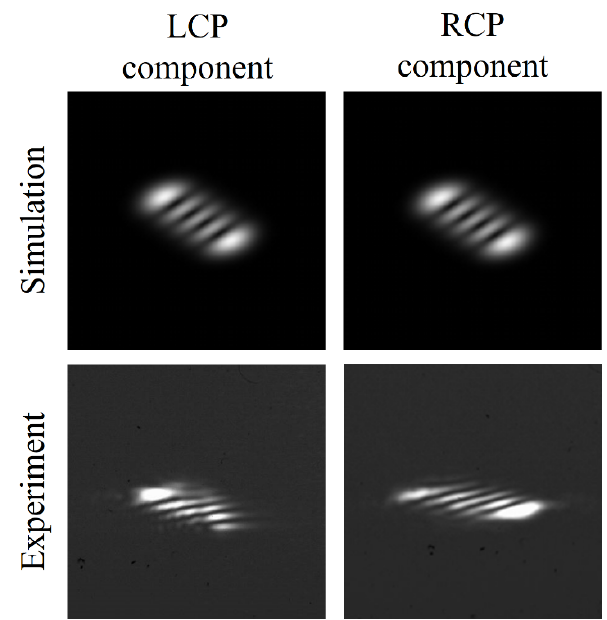
Figure 5. Numerically simulated and experimentally observed beam profiles obtained at the two detection positions of the mode characterizer for an incident OV with ℓ = 4 .